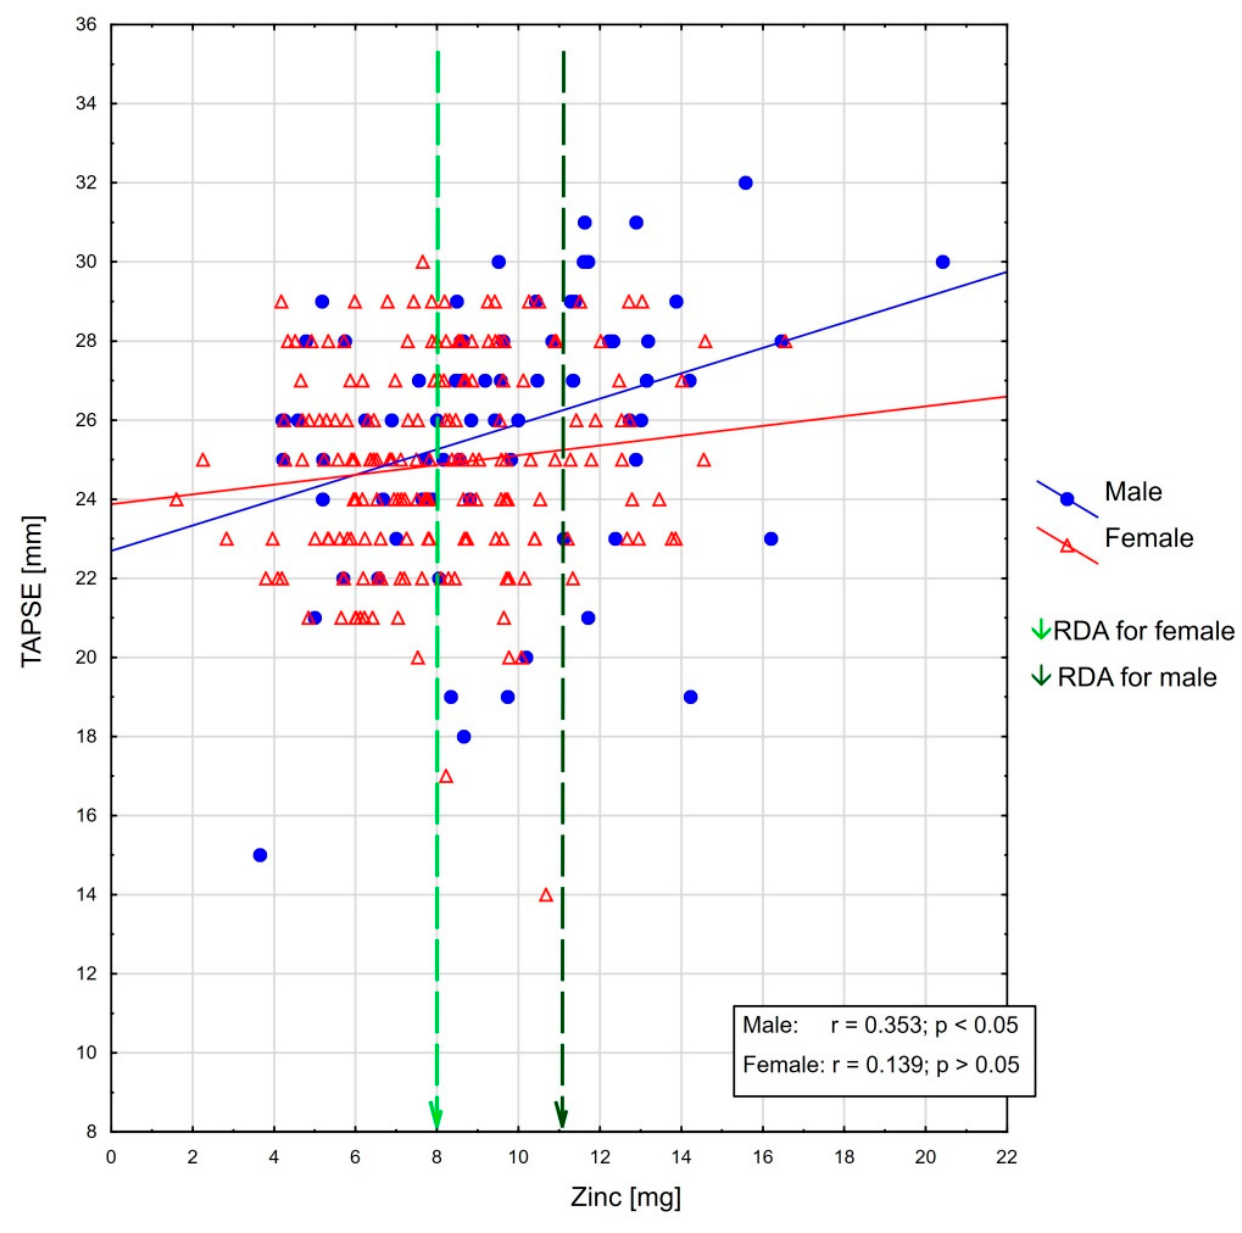
Figure 2. The association between TAPSE [mm] and zinc intake as well as RDA recommendations in the female and male groups (linear trend line added for easier interpretation).